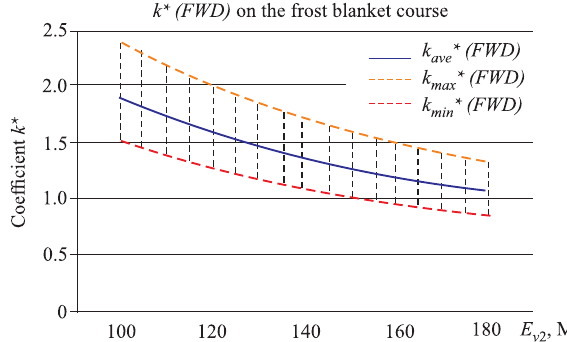
Fig. 5. Variation limits of reduction coefficient k * (FWD) measured on the frost-blanket course